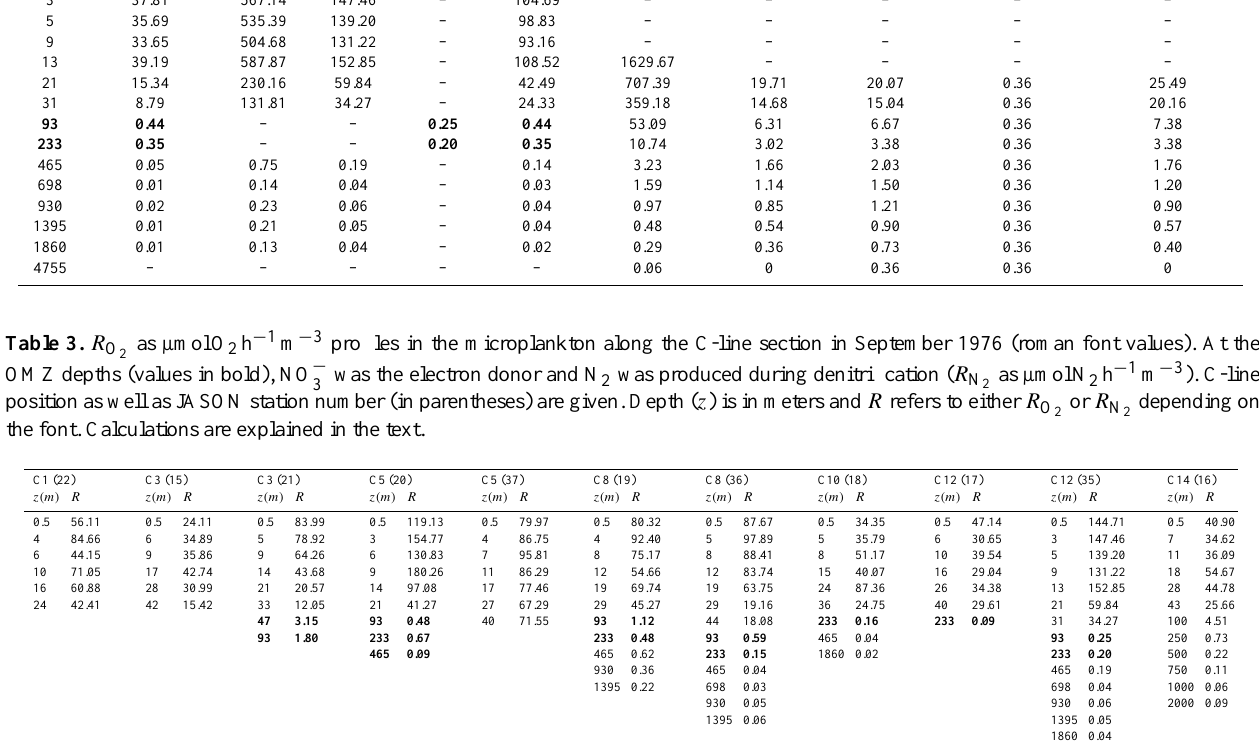
, N 2 production from Table 2. Step-by-step calculations of F C from ETS activity at C-line position C12 (station 35). Potential R ( (cid:56) ), R O 2 ) were first determined from temperature-corrected ETS activity values. (cid:56) is denitrification ( R N ) and respiratory CO 2 production ( R CO 2 2 stoichiometrically related to electrons by a factor of 4 (O 2 + 4e − + 4H + → 2H 2 O). R O is 0.26 of (cid:56) (Packard and Christensen, 2004). R N 2 2 relates to ETS activity according to Codispoti and Packard (1980). Here, denitrifying waters occur between 93 and 233m (values in bold). R CO was calculated from both R O and R N (see Sect. 2). Column 7 shows the modeled R CO values below the R maximum (13m), 2 2 2 2 = R m (z/z m ) b ) fitted to the data in Column 6. F obtained from the depth-normalized power function ( R CO C was determined by integrating 2 either to the bottom ( F t − s , Column 8) or to infinity ( F ∞ , Column 9). The first represents the C consumed by R from the Ez (21m) to the bottom, while the second includes benthic R and C burial. The difference between F ∞ and F t − s equals benthic R and the C burial rate (Column 10). Column 11 represents the C flux determined by trapezoidal approximation, which relates to F t − s through the regression